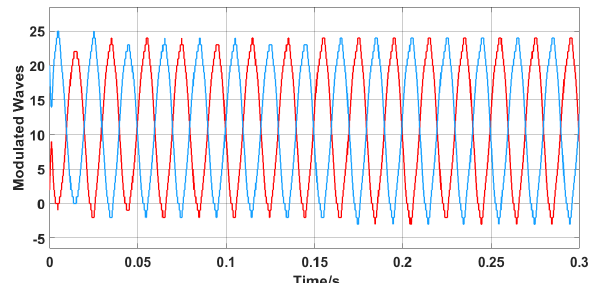
Figure 10. Modulated waves.